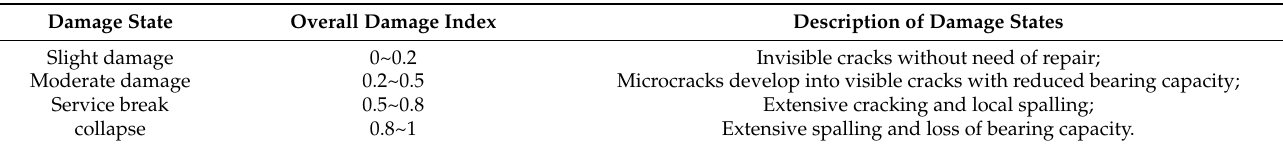
Table 3. Tensile damage state of composite lining concrete.